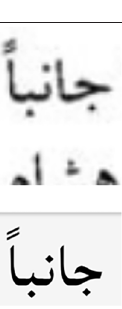
Figure 16: Missed fat